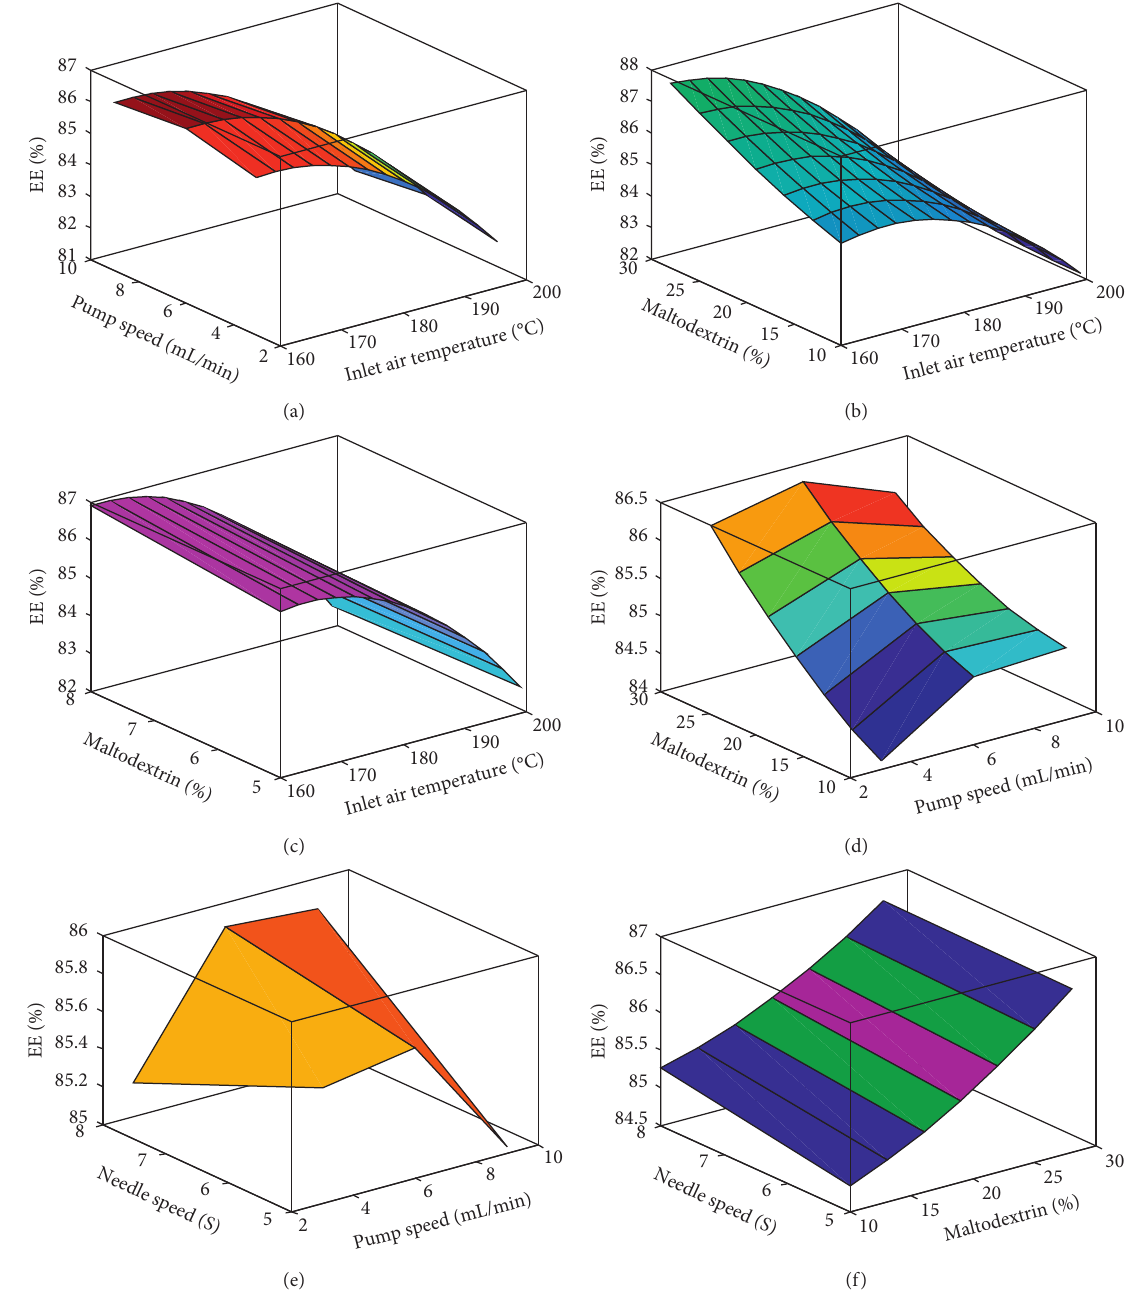
Figure 2: The interaction impact of spray drying parameters on encapsulation